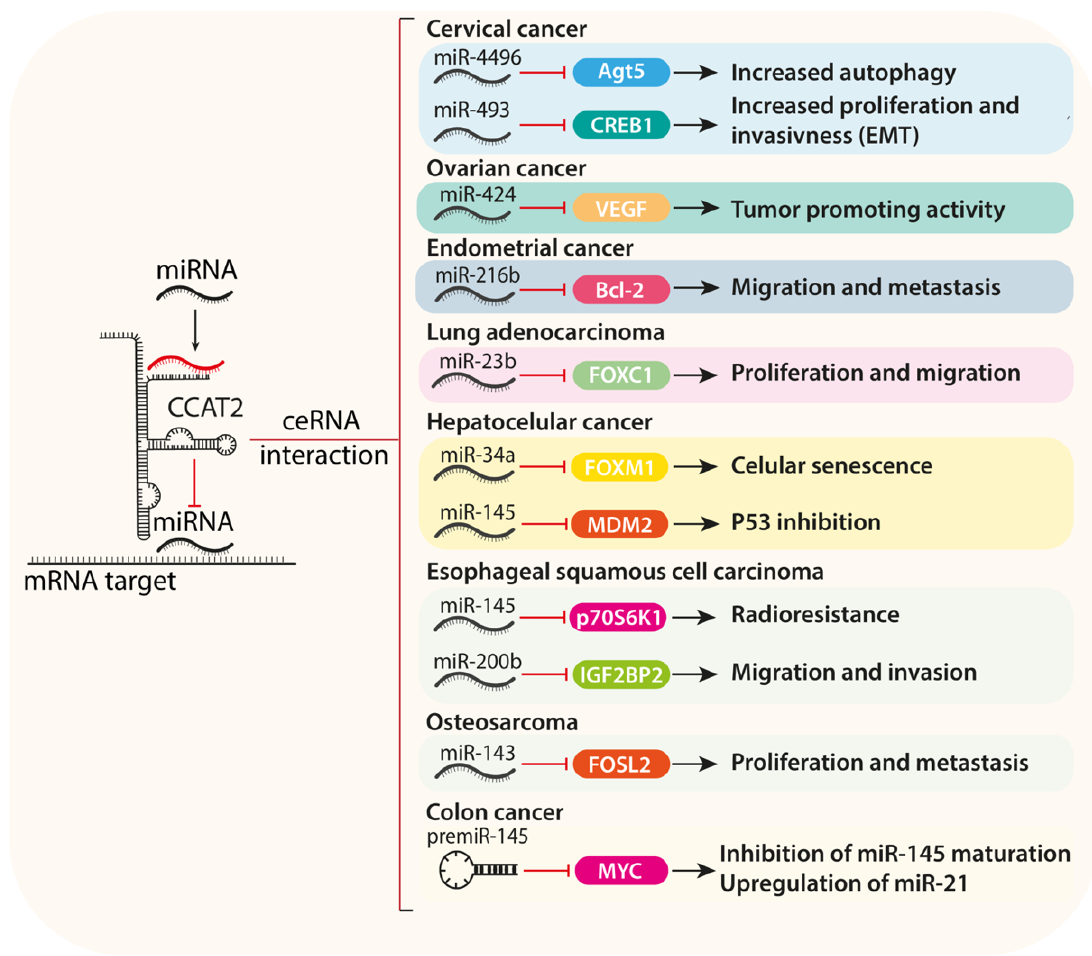
Figure 2. Currently known interactions of CCAT2 and other ncRNAs. The figure presents the effect of CCAT2 sponging on tumor suppressor miRNAs and how it influences essential cancer processes. Table 1. Currently known regulatory targets and biological effects of different expression patterns of CCAT2 in various cancer types.